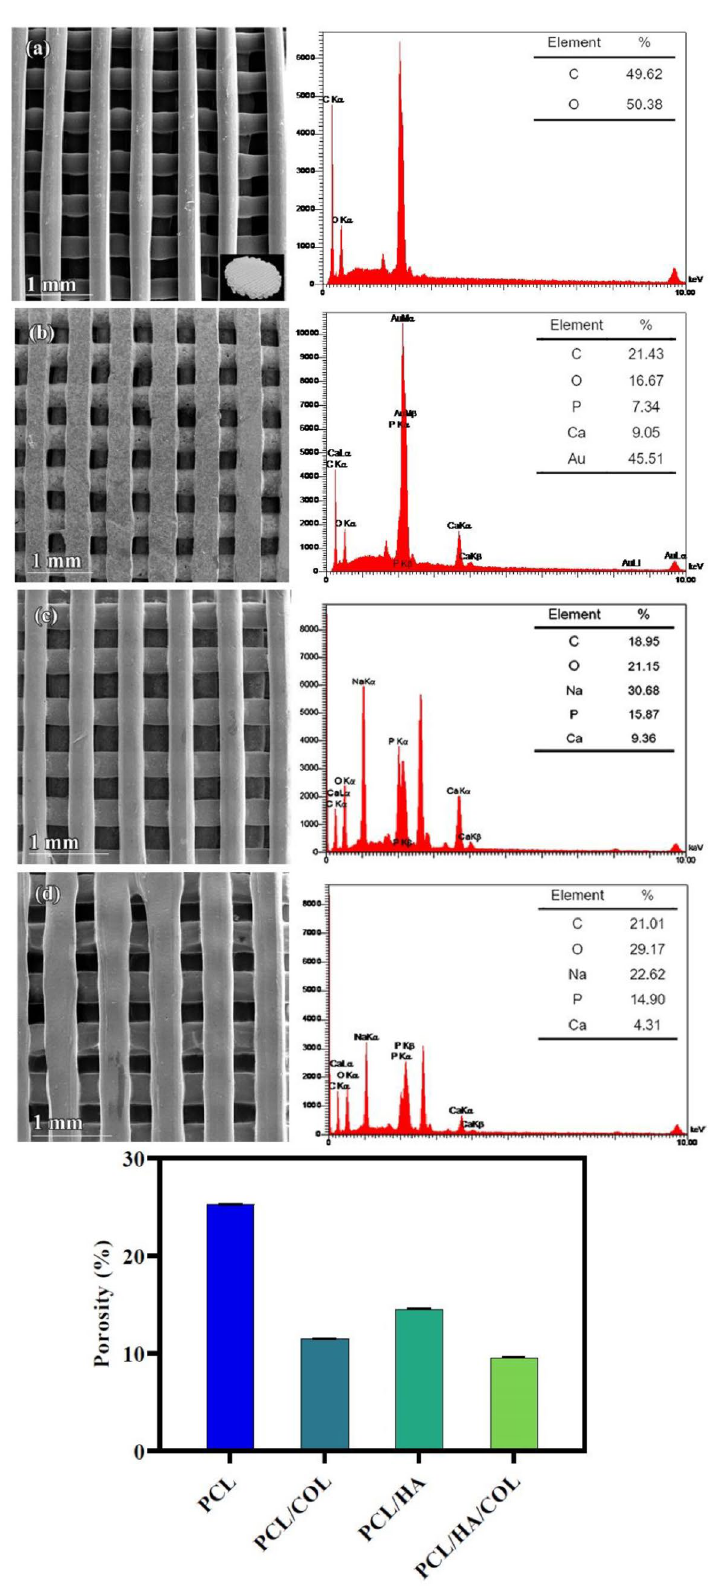
Figure 2. SEM images and EDS spectra analysis of the morphology ( a ) PCL, ( b ) PCL/HA, ( c ) PCL/COL, and ( d ) PCL/HA/COL scaffold and the change of porosity of the 3D printed